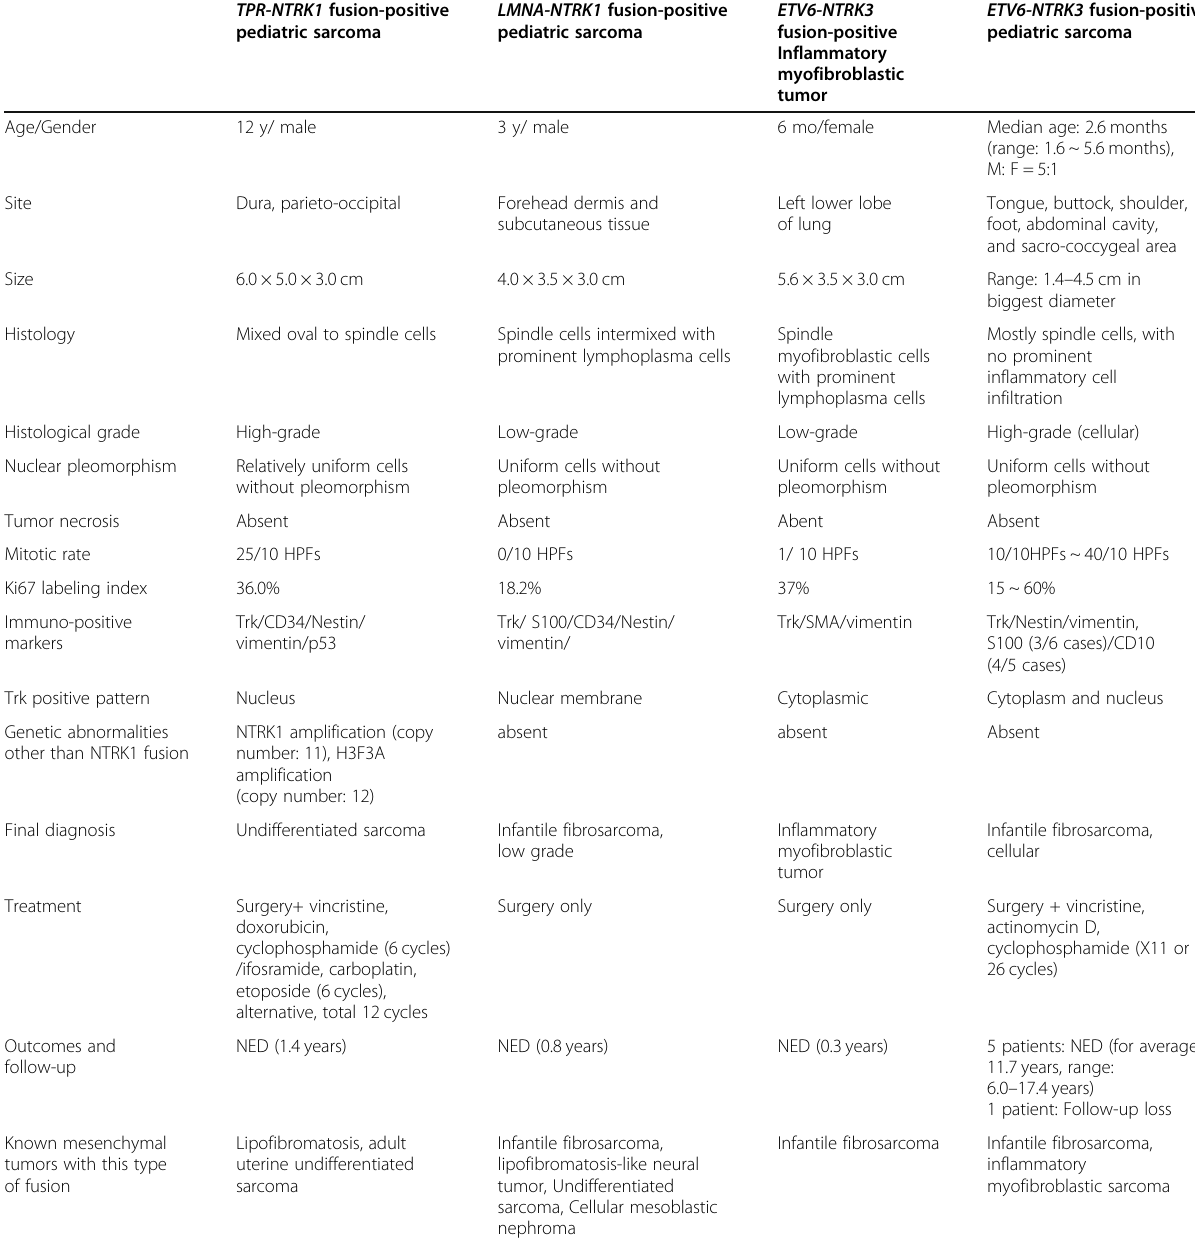
Table 1 Clinicopathological comparison of our two cases of TPR-NTRK1 and LAMA-NTRK1 fusion-positive sarcomas and 6 cases of our infantile fibrosarcoma TPR-NTRK1 fusion-positive pediatric